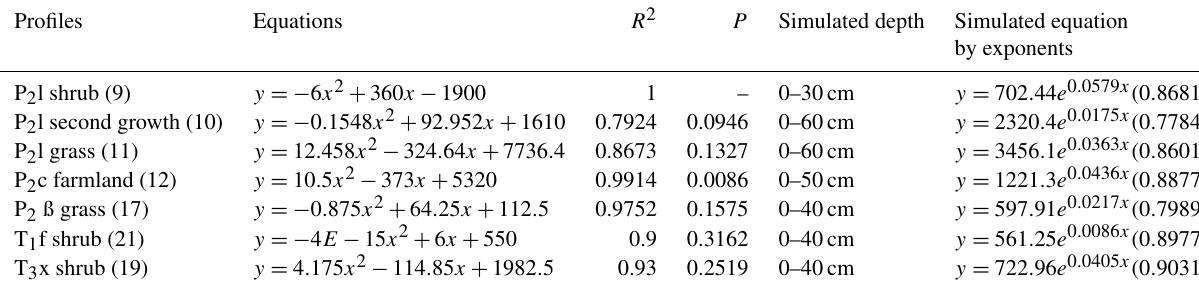
Table 4. Simulated equation of measured soil CO 2 concentration and soil depth in noncarbonate areas. Profiles